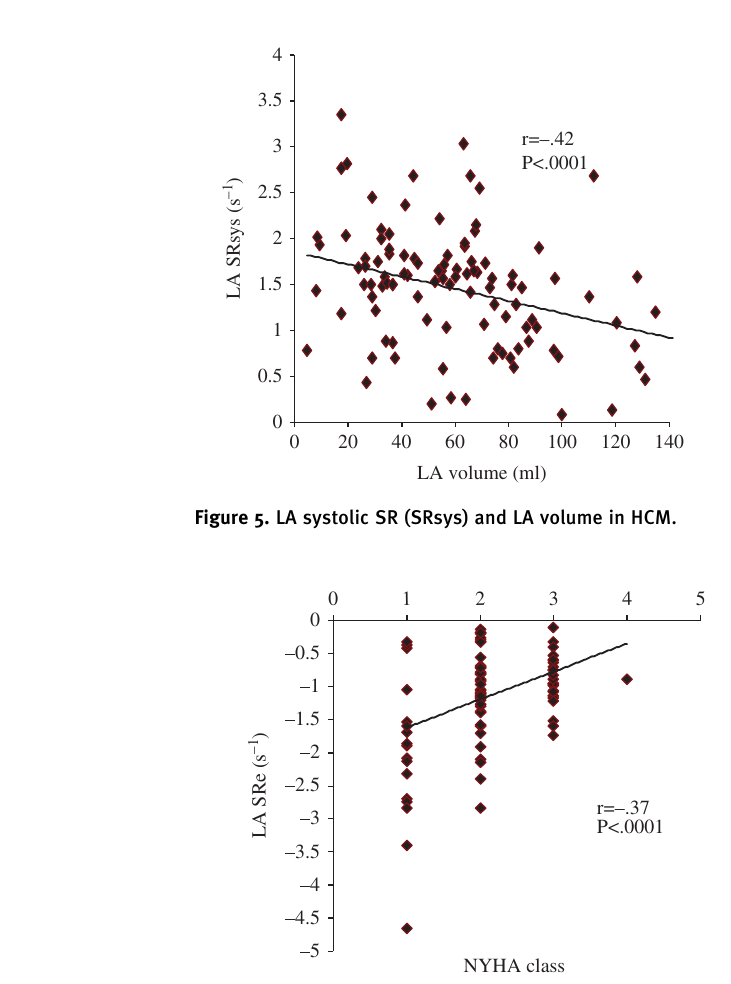
Figure 6. Relationship of LA early diastolic SR (SRe) and NYHA class in